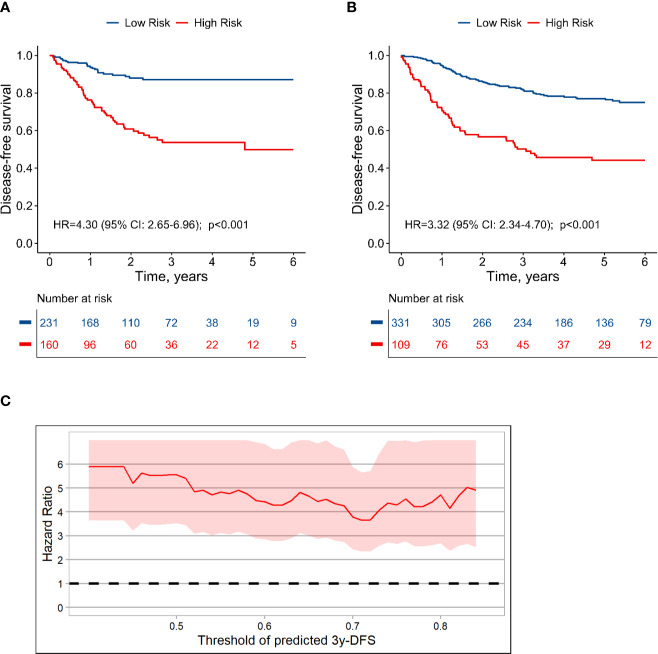
Dividing stage III colon cancer into high and low risk groups based on the TN-CEA model. (A) Disease-free survival in the training dataset. (B) Disease-free survival in the validation dataset. (C) Hazard ratio for high-risk versus low-risk group at different thresholds. This analysis was based on the predicted 3-year disease-free survival rate.